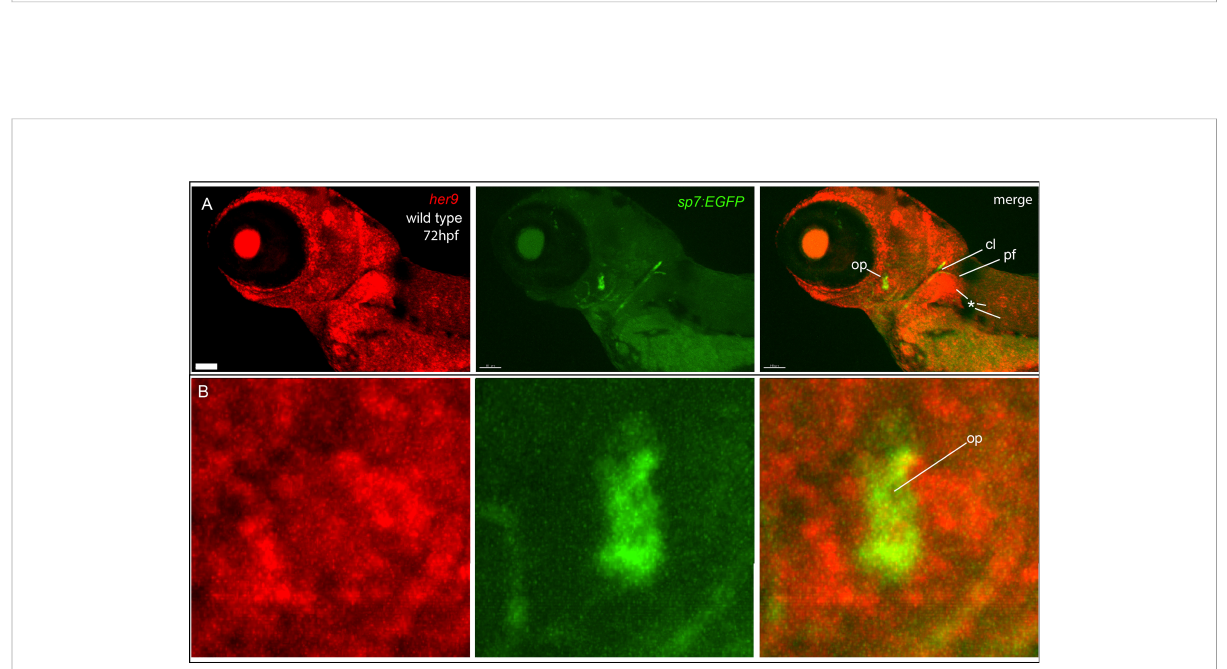
FIGURE 6 her9 is broadly expressed, but not enriched in osteoblasts. (A) In situ hybridization detects broad her9 expression at 72 hpf. Asterisks indicate areas of strong her9 expression. Opercle osteoblasts do not strongly express her9 . (B) Enlargements of images in (A) . Images in (B) are enlargements of (A) . Scale bar is 80 m